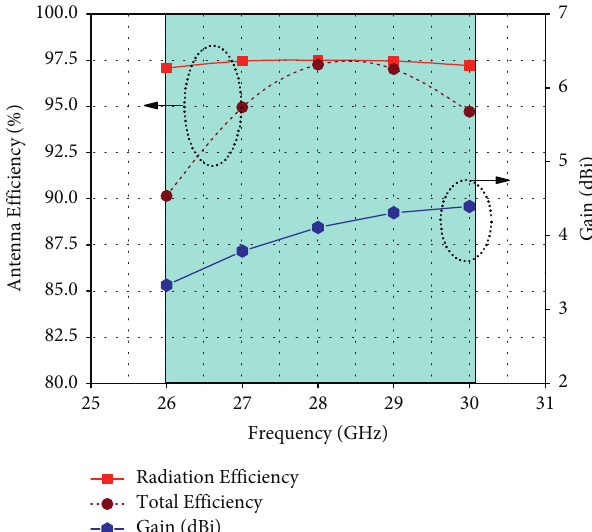
Figure 4: Performance parameters of proposed